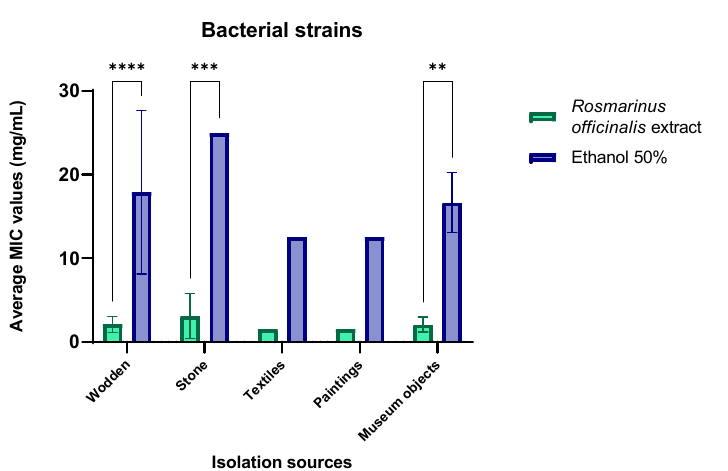
Figure 4. Graphic representation of the average values of the minimal inhibitory concentration (MIC) of R. officinalis hydro-alcoholic extract against bacterial strains expressed by the isolation sources. (** p < 0.01, *** p < 0.001, **** p < 0.0001).